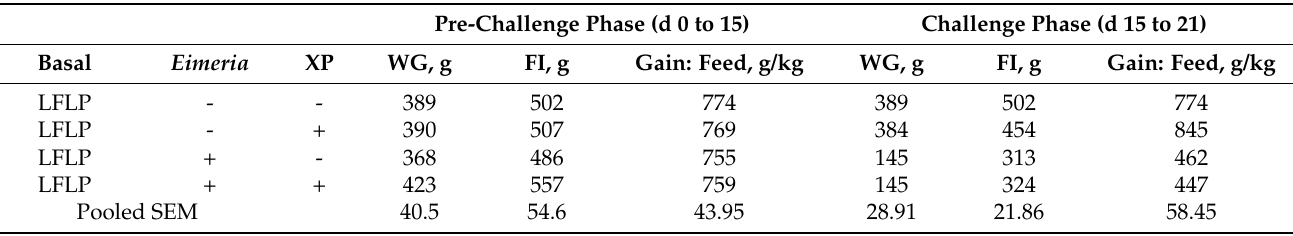
Table 5. Growth performance of the broiler chickens challenged or unchallenged with mixed Eimeria spp. in response to feeding diets with low fiber and low protein levels with or without enzymes supplementation (Expt.